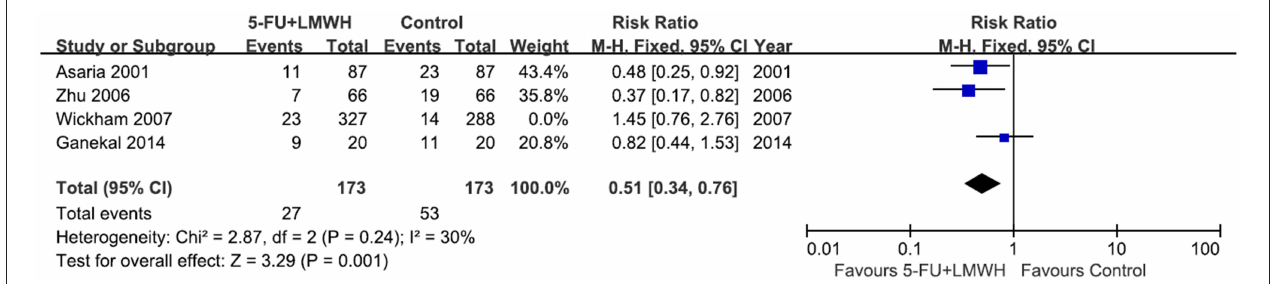
FIGURE 5 | Forest plot for the meta-analysis of postoperative PVR occurrence when the study Wickham 2007 was omitted.